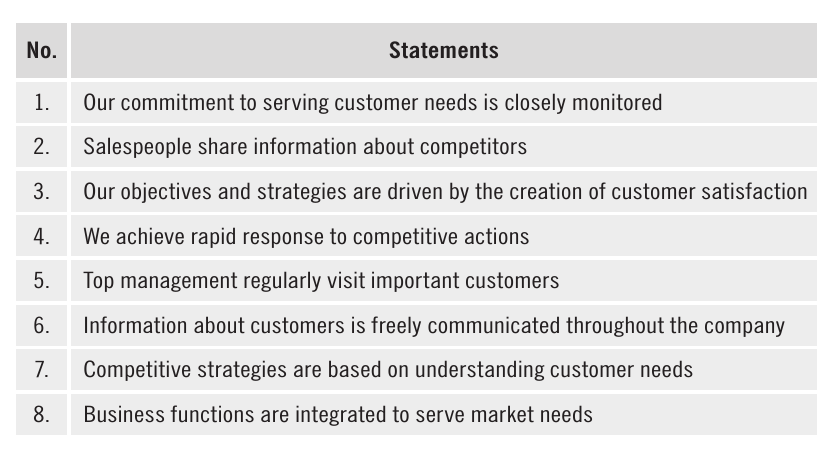
Table 5. Statements concerning the level of market orientation used in the surveys about 2011 and